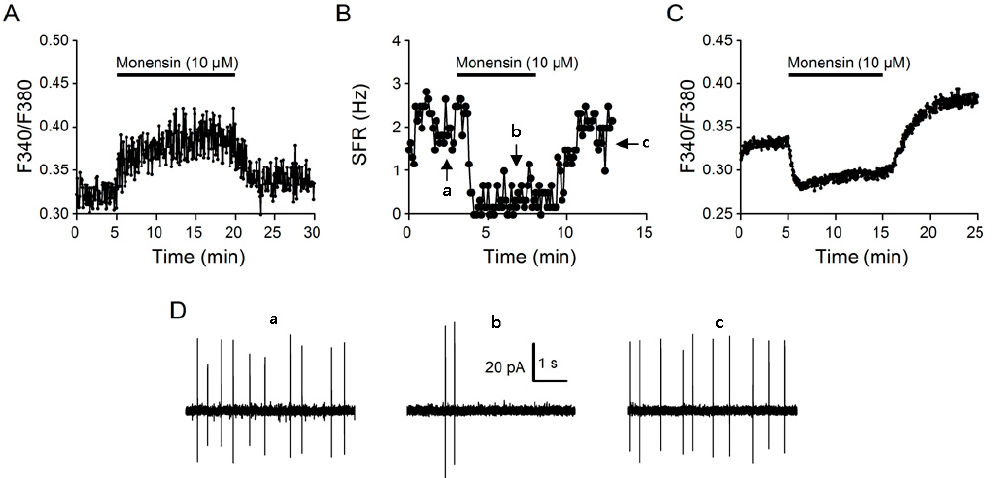
Figure 1. Monensin e ff ects on [Na + ] i ( A ), spontaneous firing rate (SFR) ( B ), and [Ca 2 + ] i ( C ) from cells in reduced SCN preparations. Representative experiments showing the e ff ect of 10 µ M monensin on [Na + ] i (an average of 13 cells) ( A ) and [Ca 2 + ] i (an average of 16 cells) ( C ). ( B ) A representative cell showing the inhibitory e ff ect of 10 µ M monensin on the spontaneous firing rate. The arrows mark where the 6-s action current traces (a,b,c) plotted in ( D ) were taken from. On average, monensin inhibits the spontaneous firing rate from 3.8 ± 0.3 Hz ( n = 15) to 0.6 ± 0.2 Hz ( n = 15; P < 0.0001; paired t -test). ( D ) Three 6-s action current traces (a,b,c) recorded with the cell-attached technique to show the e ff ects of 10 µ M monensin on the firing